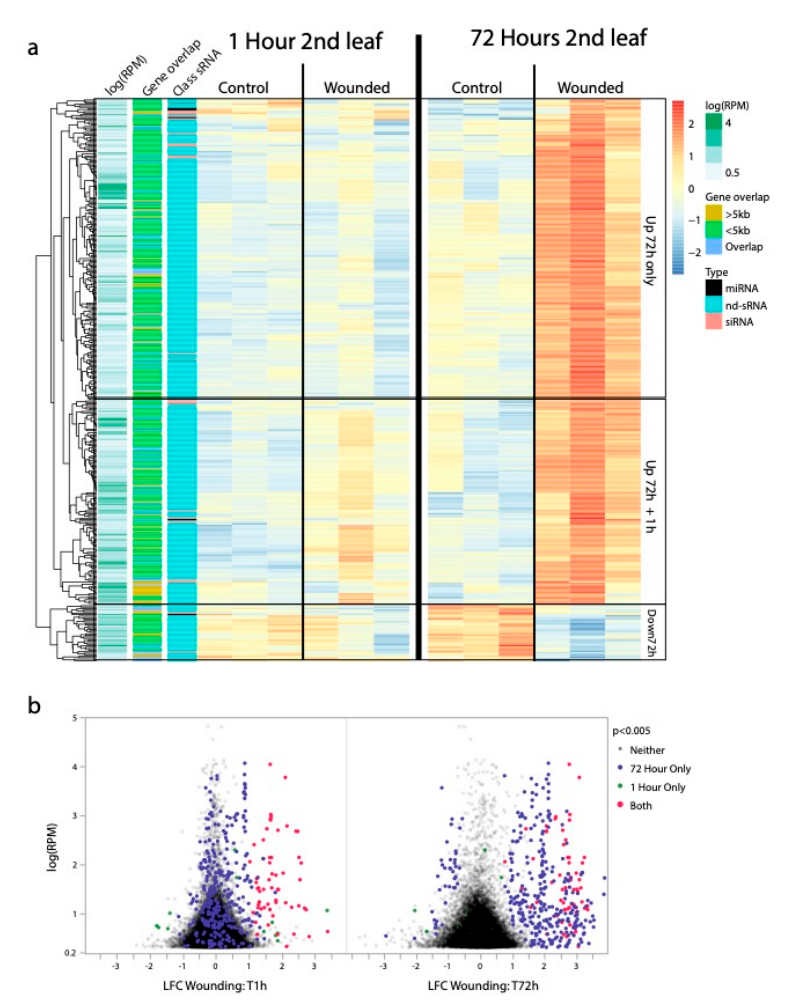
Figure 2. sRNA loci di ff erentially expressed in response to leaf wounding (FDR < 0.05) ( a ) Clustered heat map showing patterns of di ff erential sRNA production in wounded leaf tissues relative to control leaf tissues. The most striking di ff erential expression is the increased abundance of non-dicer derived sRNAs (nd-sRNAs) that are < 5 kb from but not overlapping with protein coding regions. Many of these loci only exhibit elevated sRNA production at the site of leaf wounding (2nd leaf pair) 72 h after wounding, while a subset also show less extreme elevated sRNA production at the site of leaf wounding (2nd leaf pair) 1 h after wounding. ( b ) Volcano plot of log-fold changes in sRNA production from the 2nd leaf pair 1 h and 72 h after leaf wounding. A subset of sRNA loci show immediate increased sRNA production 1 h after leaf wounding. These loci tend to still have increased sRNA production 72 h after leaf wounding but are joined by more sRNA loci that did not exhibit di ff erential sRNA production between wounded and control tissues 1 h after leaf